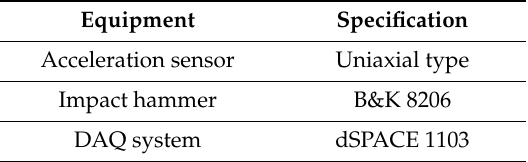
Table 4. The equipment list for modal testing.